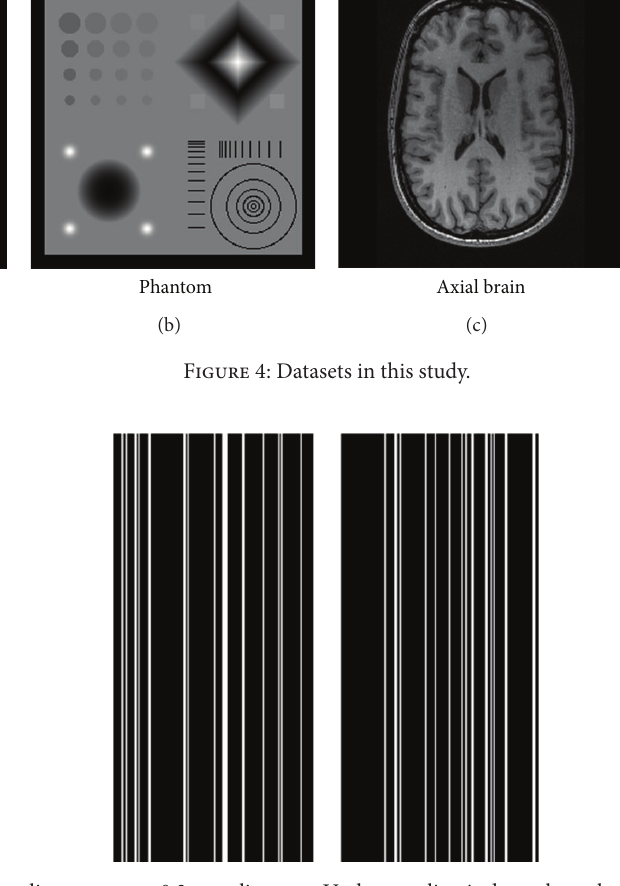
Figure 5: Sampling pattern at 0.2 sampling rate. Undersampling is done along the phase